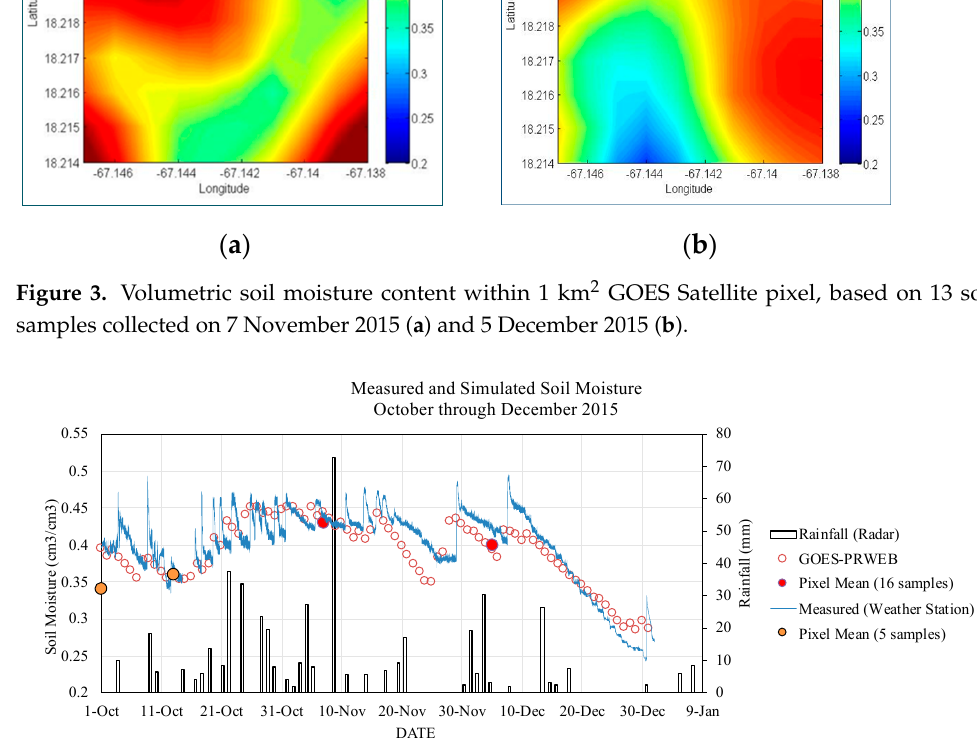
Figure 4. Comparison of θ from the mean measured pixel values from 1–13 October, 7 November and 5 December 2015, with GOES-PRWEB θ estimates and weather station θ sensors. Measured and Simulation Soil Moisture June through August 2016